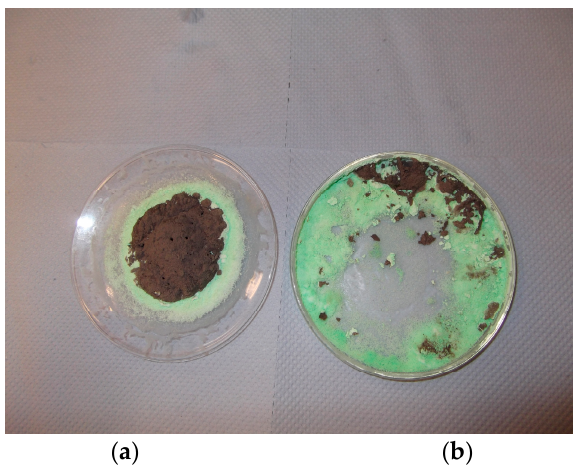
Figure 10. The effect of film formation on the structure of the material after the evaporation of water and decomposition of nitrate salt during microwave radiation of 1 M nickel nitrate in coated silica dispersion ([Ni]/[Si] = 1/4. ( a ) Reaction in a watch glass; ( b ) Treatment in a Petrie dish. Black regions contain NiO while the green regions are nickel nitrate.